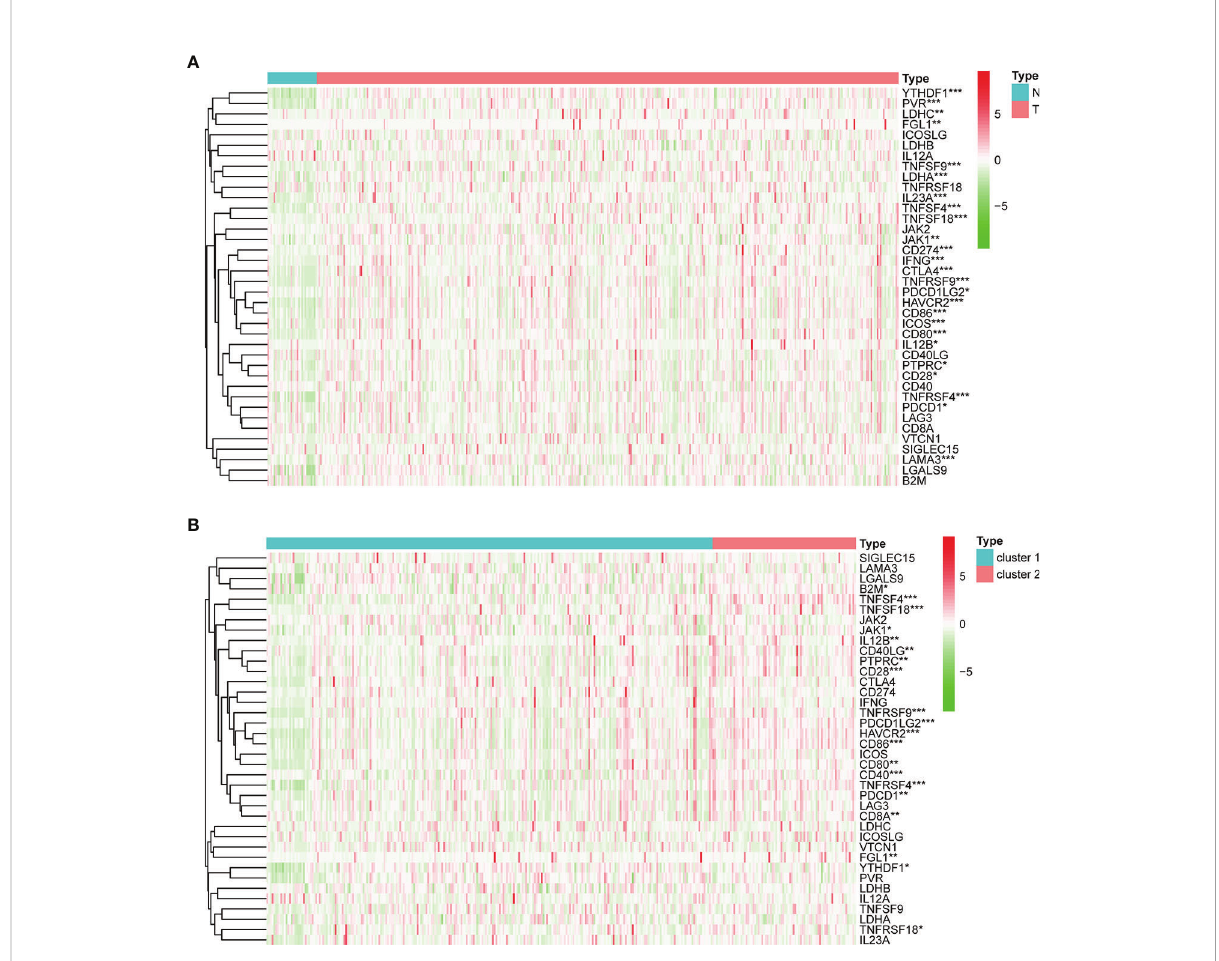
FIGURE 5 The expression of ICGs in the different subgroups. (A) Heatmap for the differential expression of ICGs between normal and tumor tissues. (B) Heatmap for the differential expression of ICGs between clusters I and II. * p < 0.05, ** p < 0.01, and *** p <